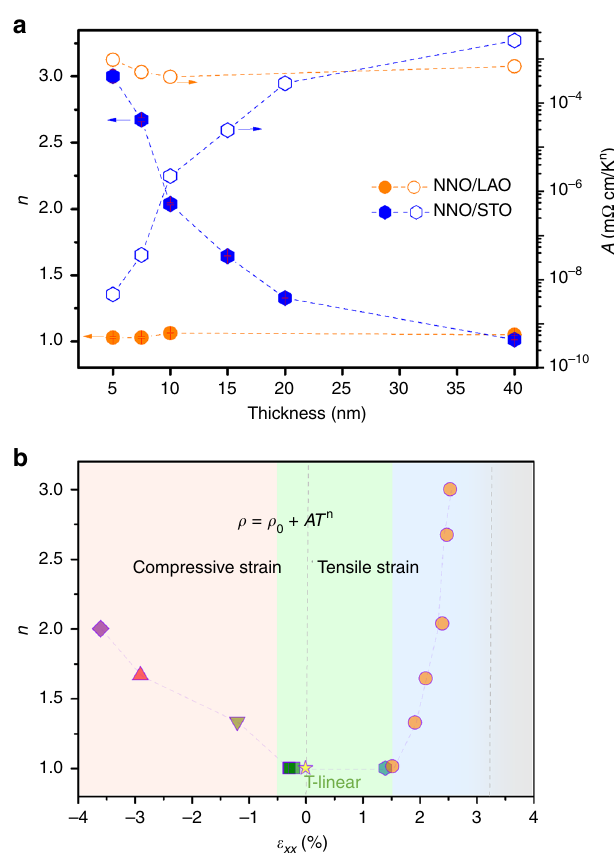
Fig. 2 Tunable exponents. a Power-law exponents ( n ) and A coef fi cients from Eq. (1), extracted from the fi ts in Fig. 1 (c, d) as a function of fi lm thickness. The error bars are determined as described in Supplementary Note 2. b Scaling exponent ( n ) as a function of in-plane strain ( ε xx ). The data are for fi lms grown on different substrates: LAO (squares), NGO (hexagon) and STO (circles). The highly tensile region shadowed in grey denotes the insulating state observed for the fi lms on DSO. In addition, we also plot n of bulk NNO 41 (star), as well as that for epitaxial NNO fi lms under compressive strain reported by Liu et al. 42 (triangles) and Mikheev et al. 43